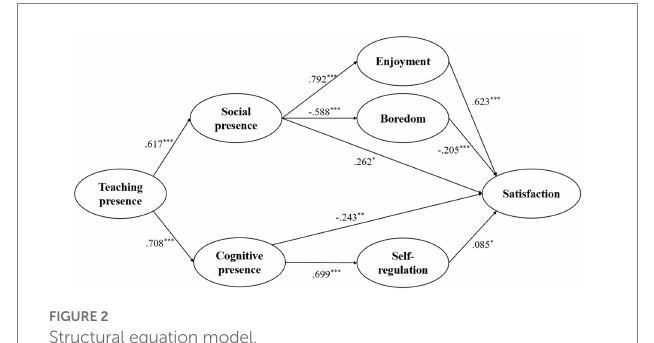
FIGURE 2 Structural equation model.